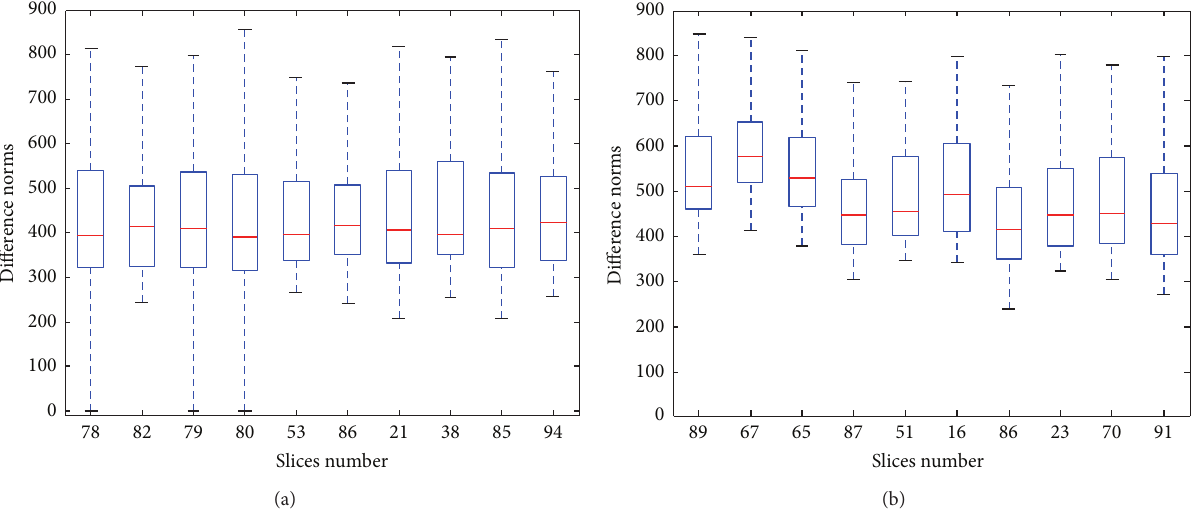
Figure 2: (a) Singular value distributions of the pairwise differences of the permittivity maps, 𝐷 𝑖 , corresponding to the 10 maps with the smallest mean value, 𝐷 𝑖 . (b) Singular value distributions of the pairwise differences of the permittivity maps, 𝐷 𝑖 , corresponding to the 10 maps with the smallest variance, 𝜎 2 𝑖